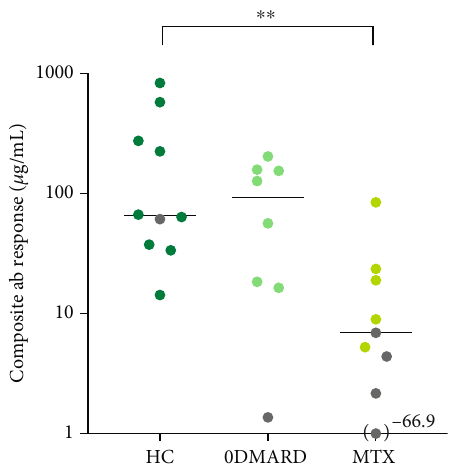
Figure 1: Composite antibody response in healthy controls, RA 0DMARD, and RA MTX groups, after immunization with 13- valent pneumococcal conjugate vaccine (PCV13). Composite antibody response represents the sum of change in pneumococcal serotype-speci fi c IgG concentrations ( μ g/mL), for 11 capsular